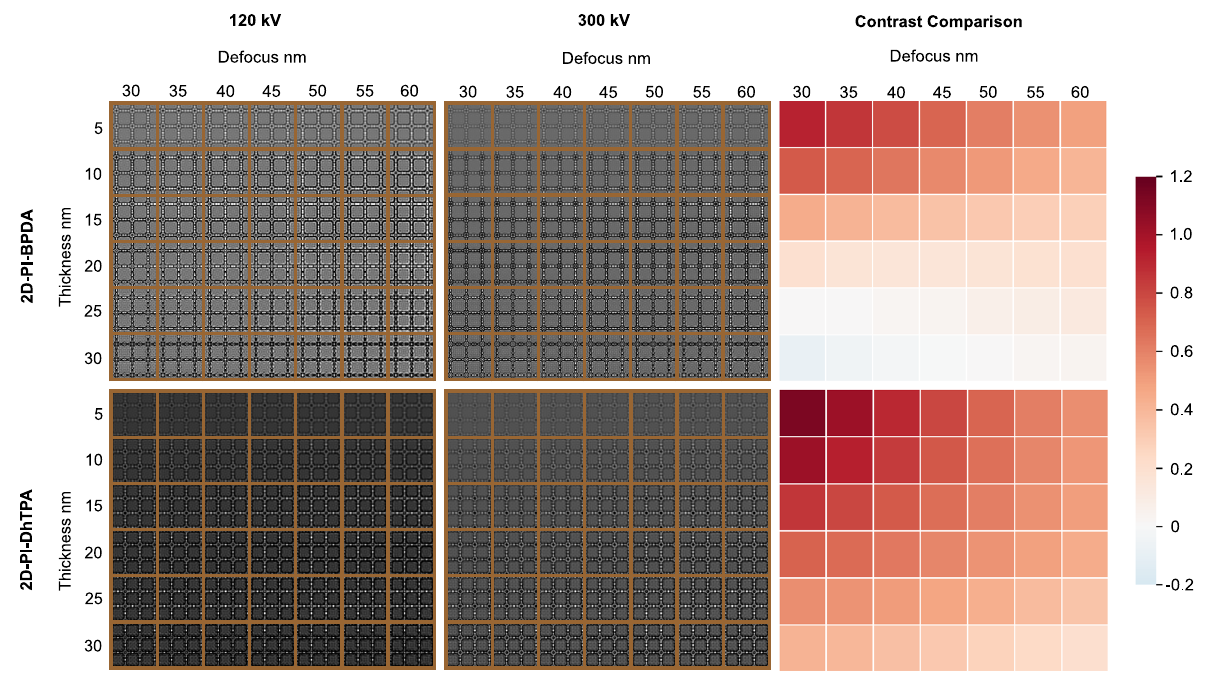
Fig. 2 Contrast comparison between 300 kV and 120 kV via image simulation. Simulated thickness-defocus maps at 120 and 300 kV of 2D-PI-BPDA and 2D-PI-DhTPA obtained by using multislice algorithm in QSTEM software. The coef fi cient of variation of the image grayscale is employed to represent the contrast. The contrast difference between 120 kV and 300 kV, i.e., (Contrast 120 -Contrast 300 )/Contrast 300 , is presented by the heat maps in the third